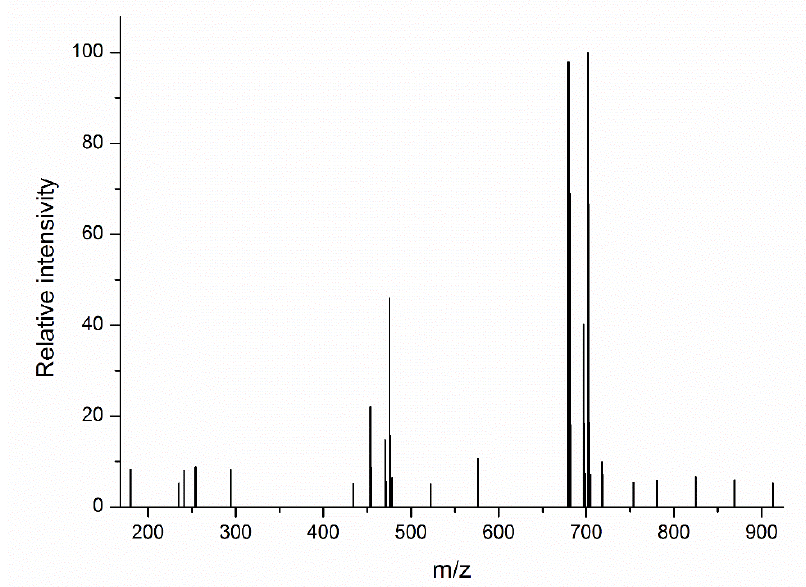
Fig. 4. Results of mass-spectrometry analysis of peptide fraction obtained from lactobacilli